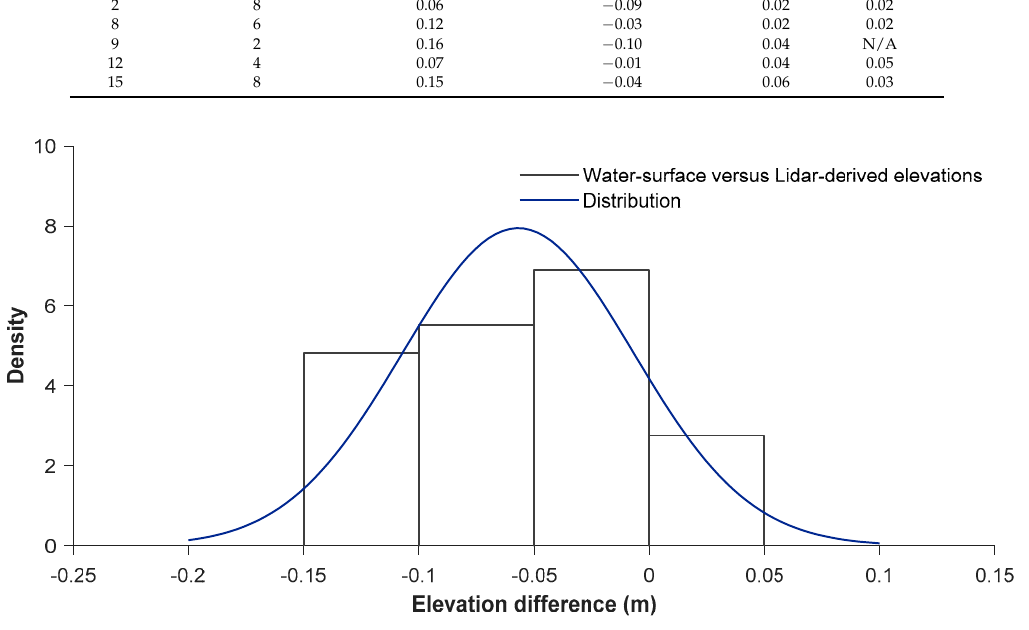
Figure 14. Distribution of water-surface elevation to Lidar-derived surface returns.